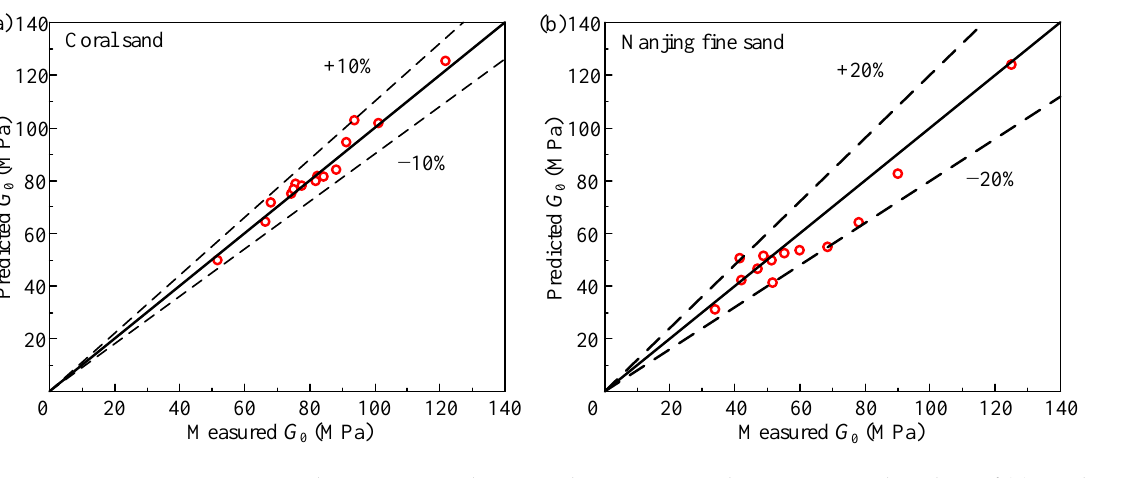
Nanjing fine sand under various consolidation conditions. ( b )